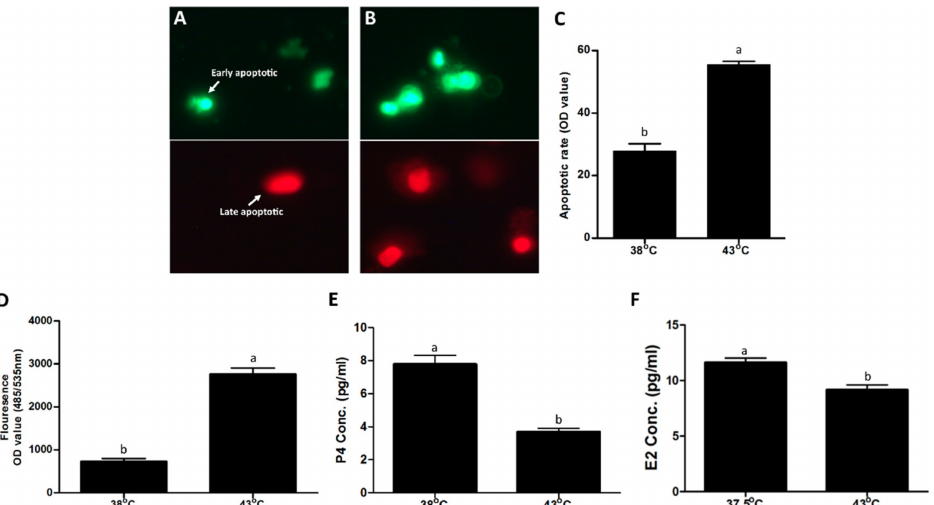
Figure 2. Comparison of physical parameters of bovine granulosa cells (GCs) exposed to heat stress (43 ◦ C for 2 h) versus control (38 ◦ C). Representative fluorescence microscope pictures (200 × ) of late apoptotic (red) and early apoptotic (green) cells after staining with FITC/PI dye for control ( A ) and heat stress treatment ( B ) groups. Means comparison of apoptotic rate (sum of red and green events) of GCs under control and heat stress ( C ). Reactive oxygen species (ROS) through fluorescence OD value (measured at 485/535 nm wavelength) of GCs stained with 2 (cid:48) ,7 (cid:48) -dichlorofluorescine diacetate (DCFDA) is shown on the y-axis, and the temperature treatments are indicated on the x-axis ( D ). Progesterone (P4) and estrogen (E2) concentration change comparison among control and heat stress groups ( E , F ), respectively. All data are represented as means ± S.E. of at least three independent cultures with at least three additional replicates for each culture. Means without common letters (a, b) are significantly different ( p <